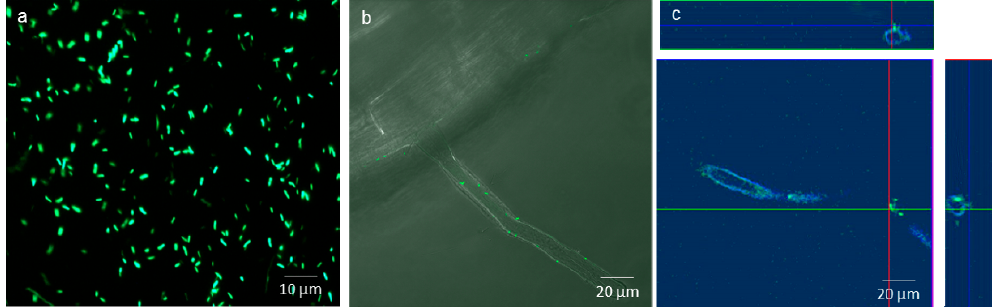
Figure 3. Confocal images of EGFP-labeled Pseudomonas sp. 262 colonising the root hairs of one-week-old seedlings of H. tuberosus D19 cultivar: ( a ) solution with EGFP-labeled Pseudomonas sp. strain 262 with blue light (488 nm) excitation; ( b ) single cells attached to a root hair; and ( c ) ortho-image of the root hair, showing bacterial cells (green) inside plant cells (in blue). In our study, the EGFP-labeled bacterial strain was found in the root interior of H. tuberosus in the studied conditions. Since the inoculated bacterial cells were also found attached to the root hair